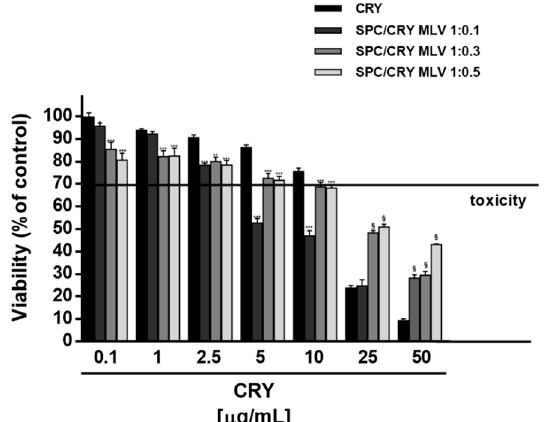
Figure 7. Cytotoxicity of SPC MLV differently loaded with CRY (1:0.1, 1:0.3 and 1:0.5 mol/mol) in MDA-MB-468 cells after 24 h incubation. ** p < 0.01 and *** p < 0.001 vs. CRY, denotes a statistically